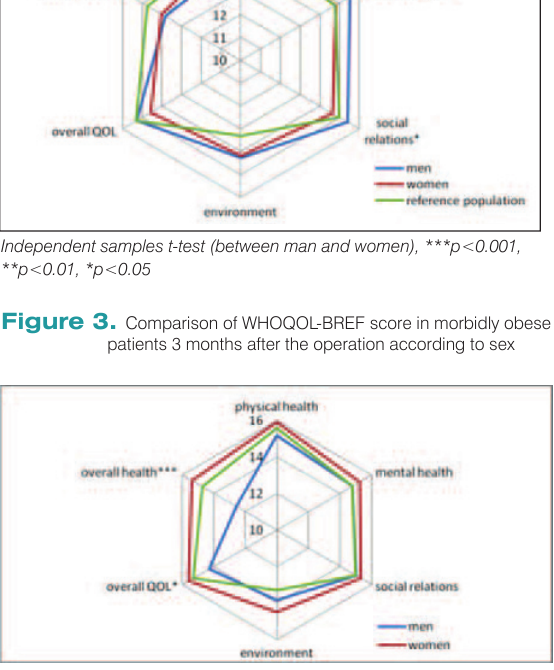
Figure 1. The comparison of WHOQOL-BREF score between obese patients during bariatric treatment and population standards